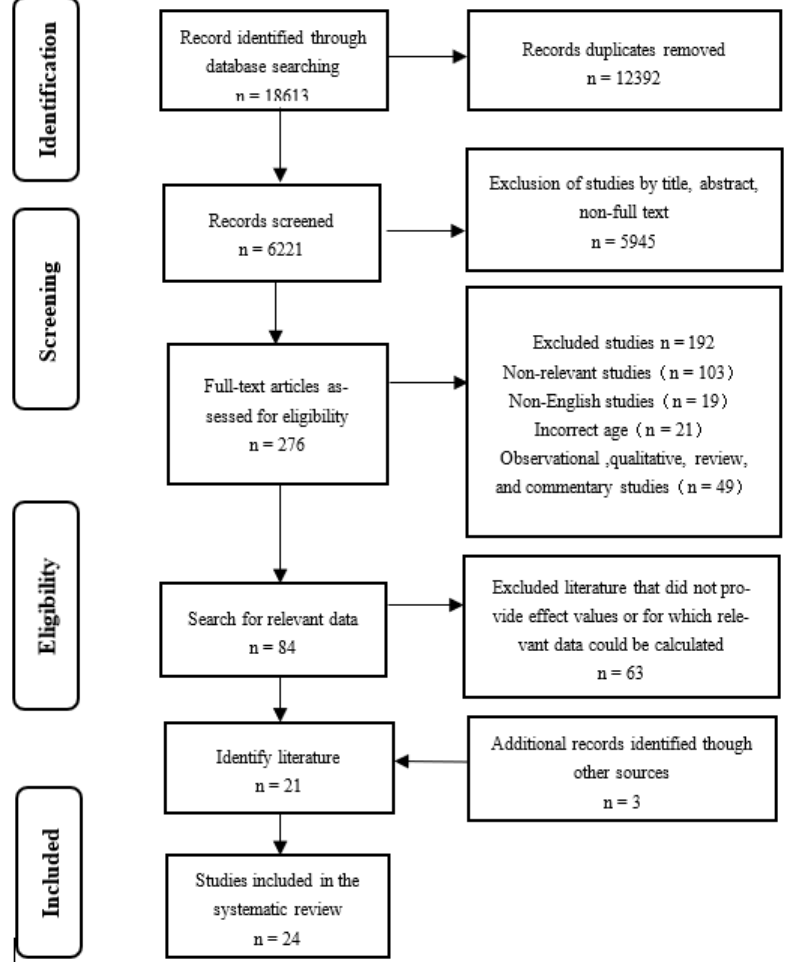
Figure 1. Flow chart of literature retrieval.